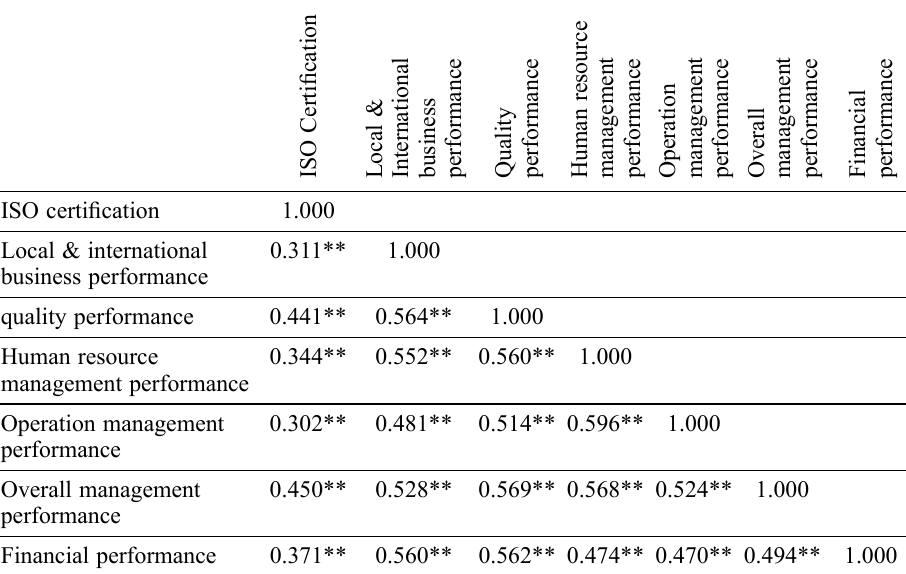
Table 3. Inter-correlation between variables included in this study (N = 201)